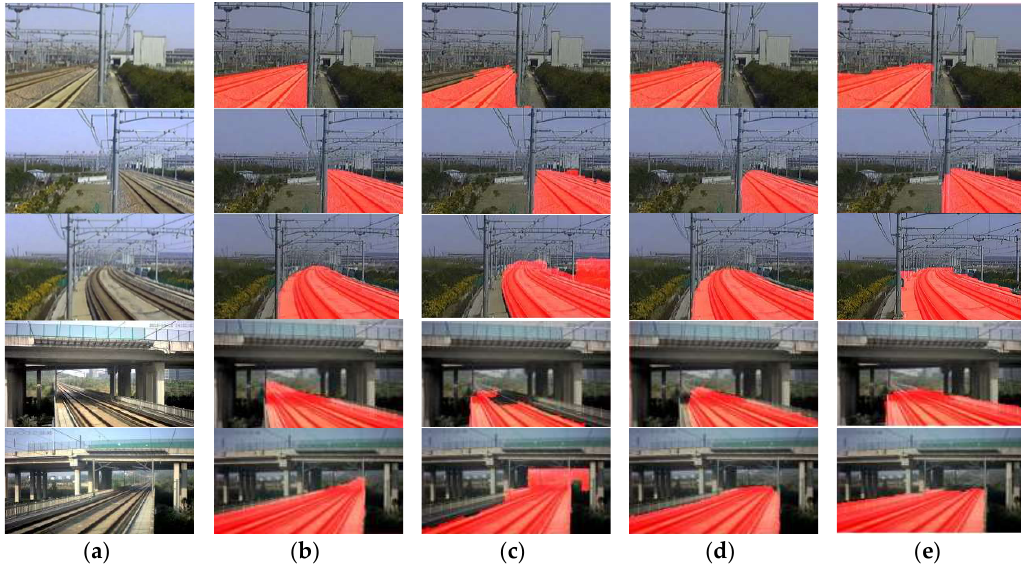
Figure 14. Using different algorithm to detect the track area. ( a ) The original railway scenes. ( b ) Ground truth of track areas. ( c ) Results of the MCG algorithm. ( d ) Results of the FCN algorithm. ( e ) Results of our algorithm.